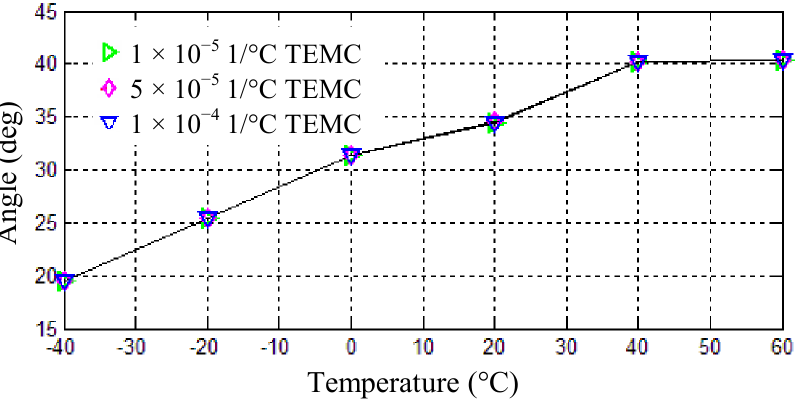
Figure 10. Position shifts of one antinode axis induced by thermal elastic modulus coefficient.